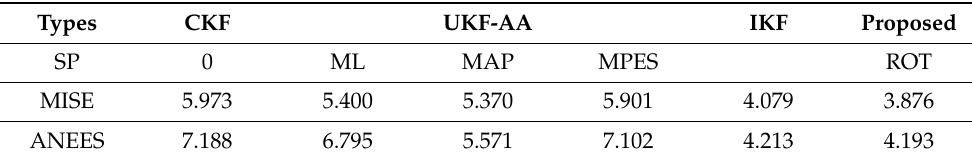
Table 3. Comparison results of the filter performance.